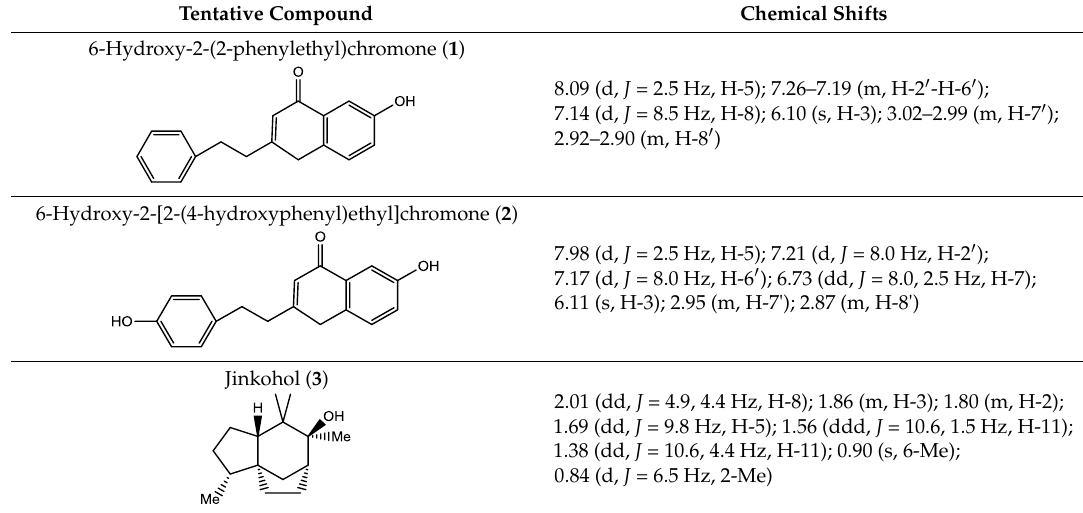
Figure 1. 1 H-NMR spectra of eight groups (A-H) of A . malaccensis gaharu samples of different grades. Metabolites labeled with numbers were tentatively identified. The spectra are arranged according to the selling price of the gaharu samples, from grades A (the most expensive) through B, C, D, E, F, G to H (the cheapest), respectively. Table 1. Identified metabolites in the 1 H-NMR spectra of ( A. malaccensis ) gaharu samples.